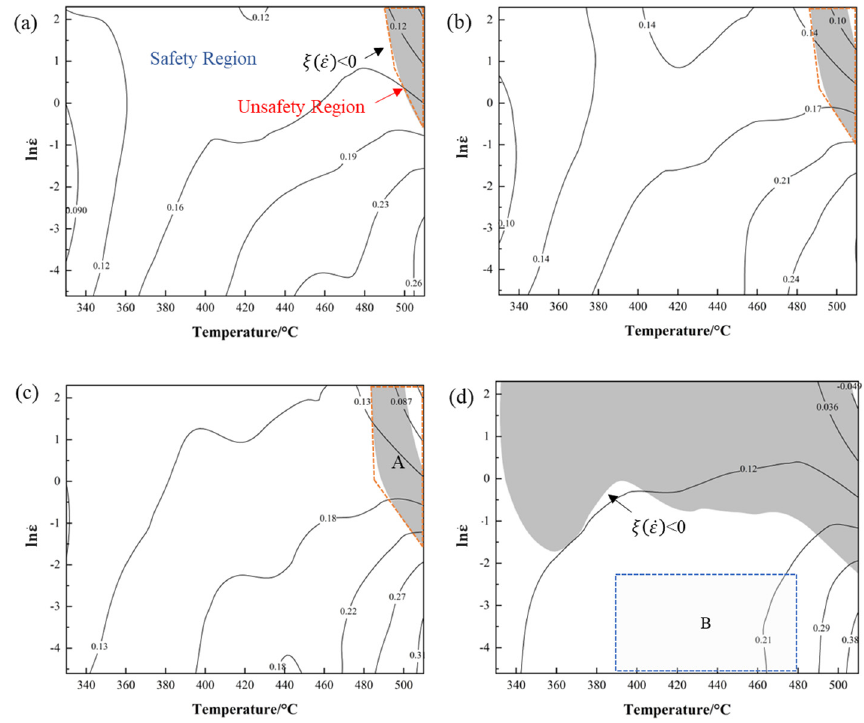
Figure 7. Processing maps under di ff erent strain rates: ( a ) 𝜀 = 0.2, ( b ) 𝜀 = 0.4, ( c ) 𝜀 = 0.6, and ( d ) 𝜀 =